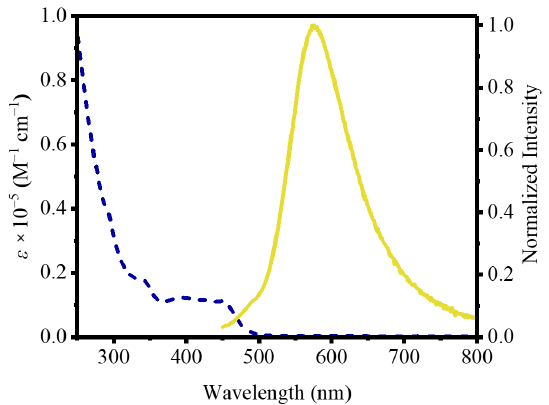
Figure 2. The UV-Vis absorption (blue dash) and normalized emission (yellow solid) spectra of an Au 4 Cu 2 cluster in a CH 2 Cl 2 solution at ambient temperature (excitation at 397 nm).